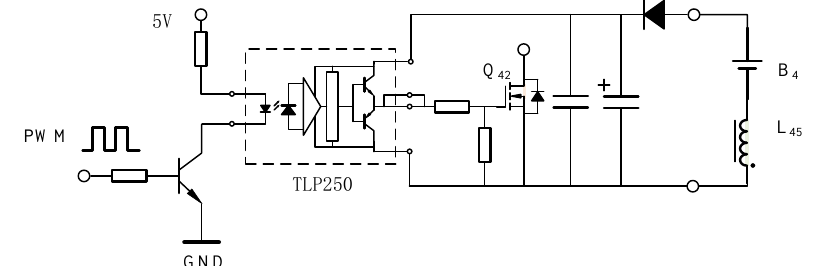
Figure 5. Optocoupler isolated driving circuits for the switches whose source is connected to the wind of multi-winding transformer.